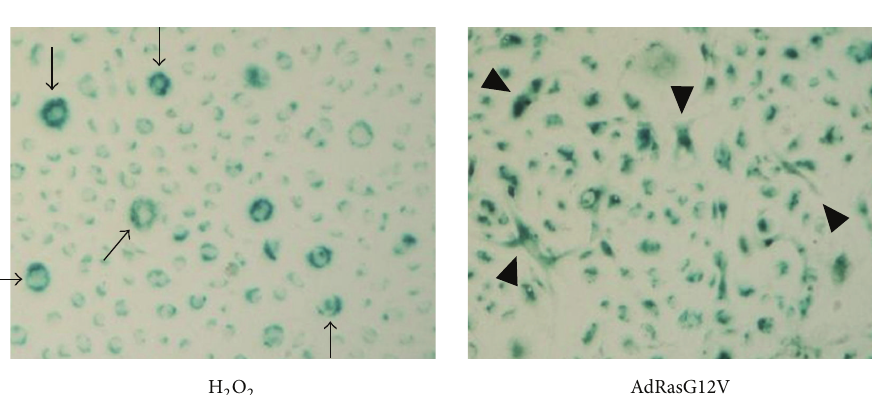
Figure 1: SA- 𝛽 -Gal staining of HUVECs. HUVECs were infected with AdRas12V for 1 week to induce senescence or with AdGFP as the negative control. Senescence was also induced in HUVECs treated with 100 𝜇 mol/L H 2 O 2 for 1hr. Arrows indicate large and round-shaped senescent cells, and arrowheads indicate flat or spindle-shaped senescent cells.